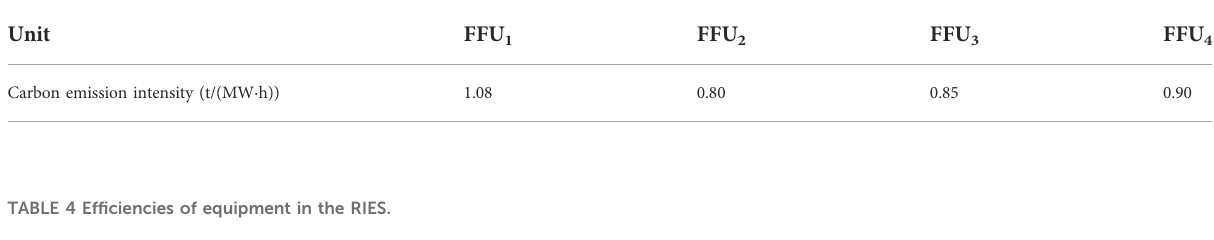
TABLE 3 Carbon emission intensity of different types of units.